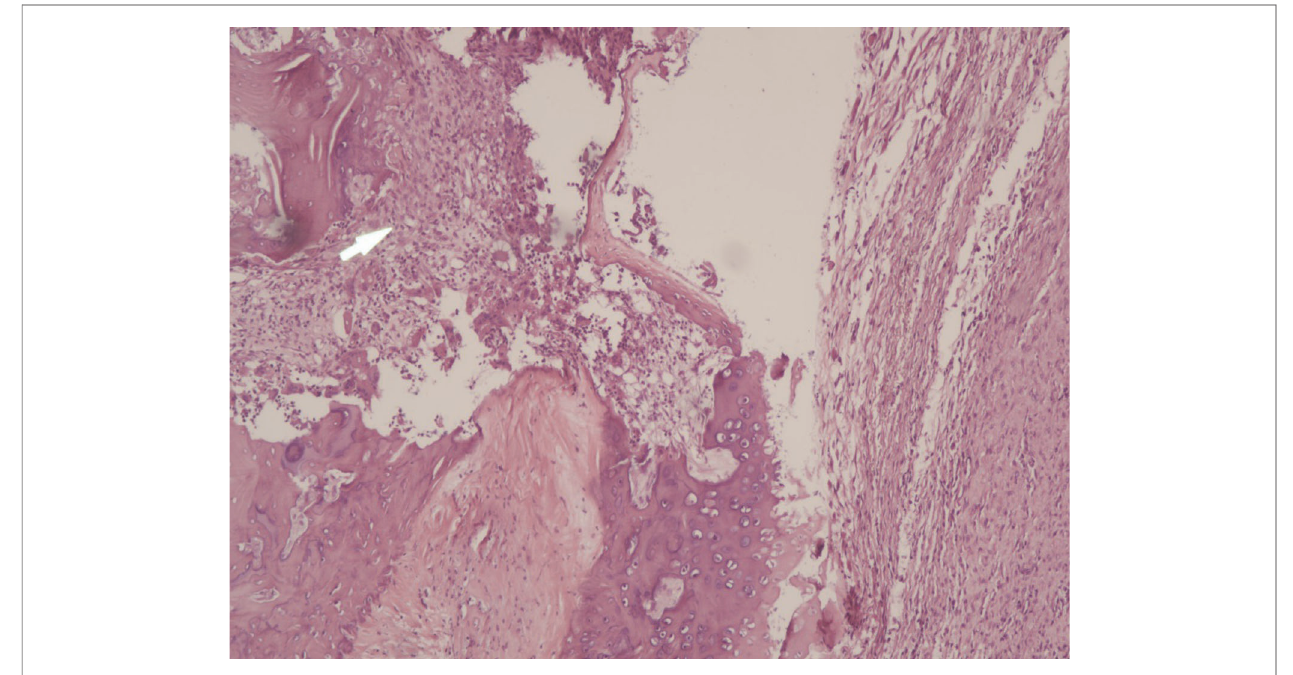
FIGURE 1 | Rat osteoarthritis(Cartilage cell hypertrophy and